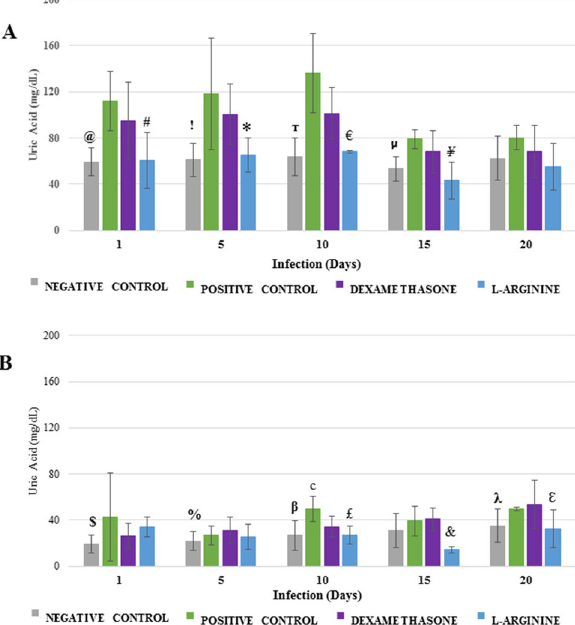
Figure 6. Uric acid levels in the lungs ( A ) and brains ( B ) of Plasmodium berghei -infected Swiss mice. Animals were pretreated and received a daily dose of DEXAMETHASONE, L-ARGININE, or PBS (CONTROL). @ p < 0.0001 versus POSITIVE CONTROL and p = 0.0013 versus DEXAMETHASONE; # p = 0.0033 versus DEXAMETHASONE and p = 4.3 × 10 −6 versus POSITIVE CONTROL; ! p = 0.0016 versus POSITIVE CONTROL and p = 0.0003 versus DEXAMETHASONE; *p = 0.00058 versus POSITIVE CONTROL; т p < 0.0001 versus POSITIVE CONTROL and p = 0.0002 versus DEXAMETHASONE; € p = 0.00095 versus POSITIVE CONTROL and p = 0.00054 versus DEXAMETHASONE; μ p = 0.0001 versus POSITIVE CONTROL and p = 0.0139 versus DEXAMETHASONE; ¥ p = 0.00071 versus POSITIVE CONTROL and p = 0.01167 versus DEXAMETHASONE; $ p = 0.0004 versus L-ARGININE; c p = 0.0080 versus DEXAMETHASONE and p = 0.0024 versus L-ARGININE; % p = 0.0426 versus DEXAMETHASONE; β p = 0.0032 versus POSITIVE CONTROL; £ p = 0.0479 versus DEXAMETHASONE; & p = 0.0029 versus POSITIVE CONTROL and p = 0.0001 versus DEXAMETHASONE; λ p = 0.0398 versus L-ARGININE; ε p = 0.0395 versus POSITIVE CONTROL and p = 0.0407 versus